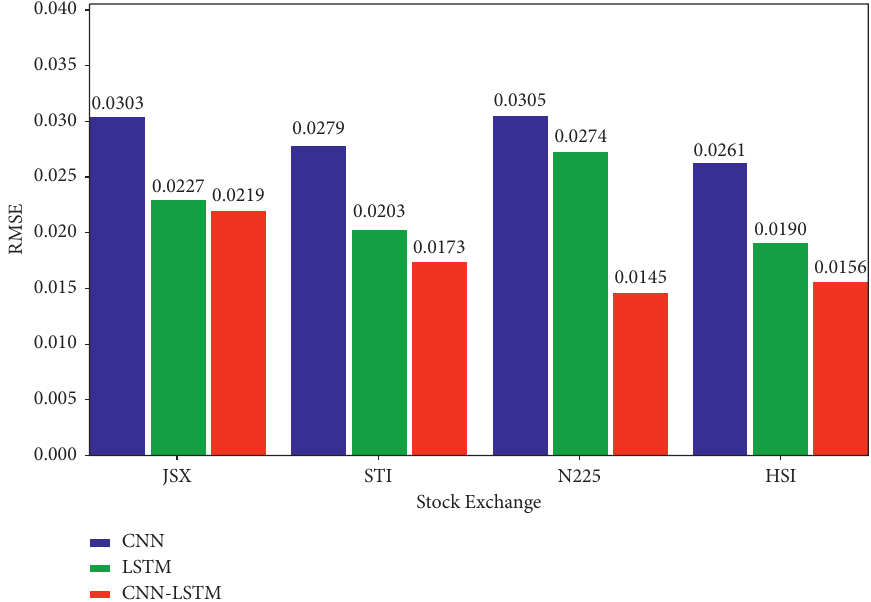
Figure 7: RMSE comparison between CNN, LSTM, and multivariate CNN-LSTM when predicting data in the training phase, i.e., the first 170 trading days of the year